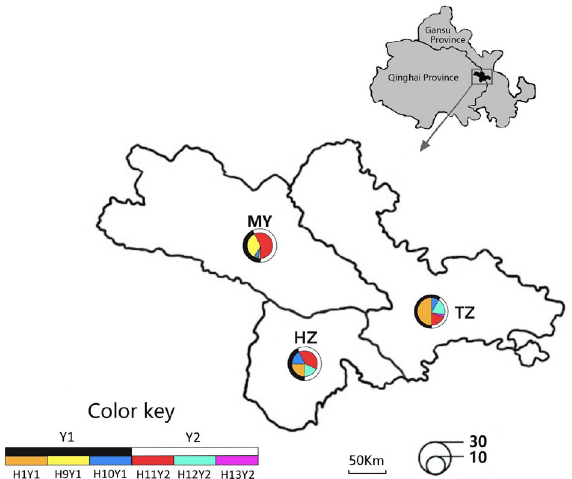
Figure 1. Sampling sites and haplotype/haplogroup distributions of three Chinese white yak breeds/ populations. Maps is created using ArcGIS software. Note: TZ, Tianzhu white yak; MY, Menyuan white yak; HZ, Huzhu white yak. The shaded grey area shows Gansu Province and Qinghai Province of China, and the shaded black area within grey area represents Tianzhu County in Gansu Province, and Huzhu and Menyuan Counties in Qinghai Province. The different colors in each circle represent different haplotypes/haplogroups identified. The size of the circle is proportional to the number of individuals. The distances among breeds/populations were measured from the center of the pie